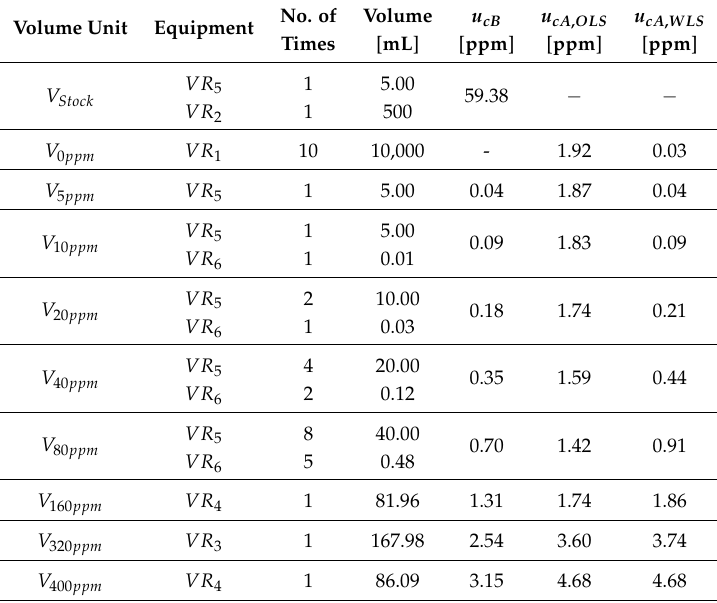
Table 8. Measured type B uncertainties of sampling and type A uncertainties of the OiW monitors’ confidence interval estimated in the